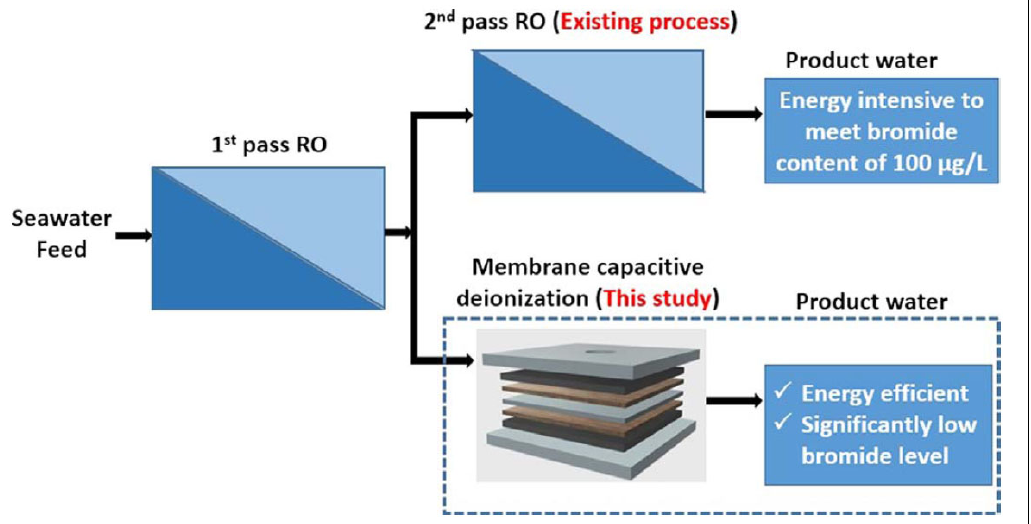
Figure 8. Conceptual diagram of reverse osmosis–capacitive deionization (RO–CDI) process replacing second ‐ pass RO with CDI [55] .